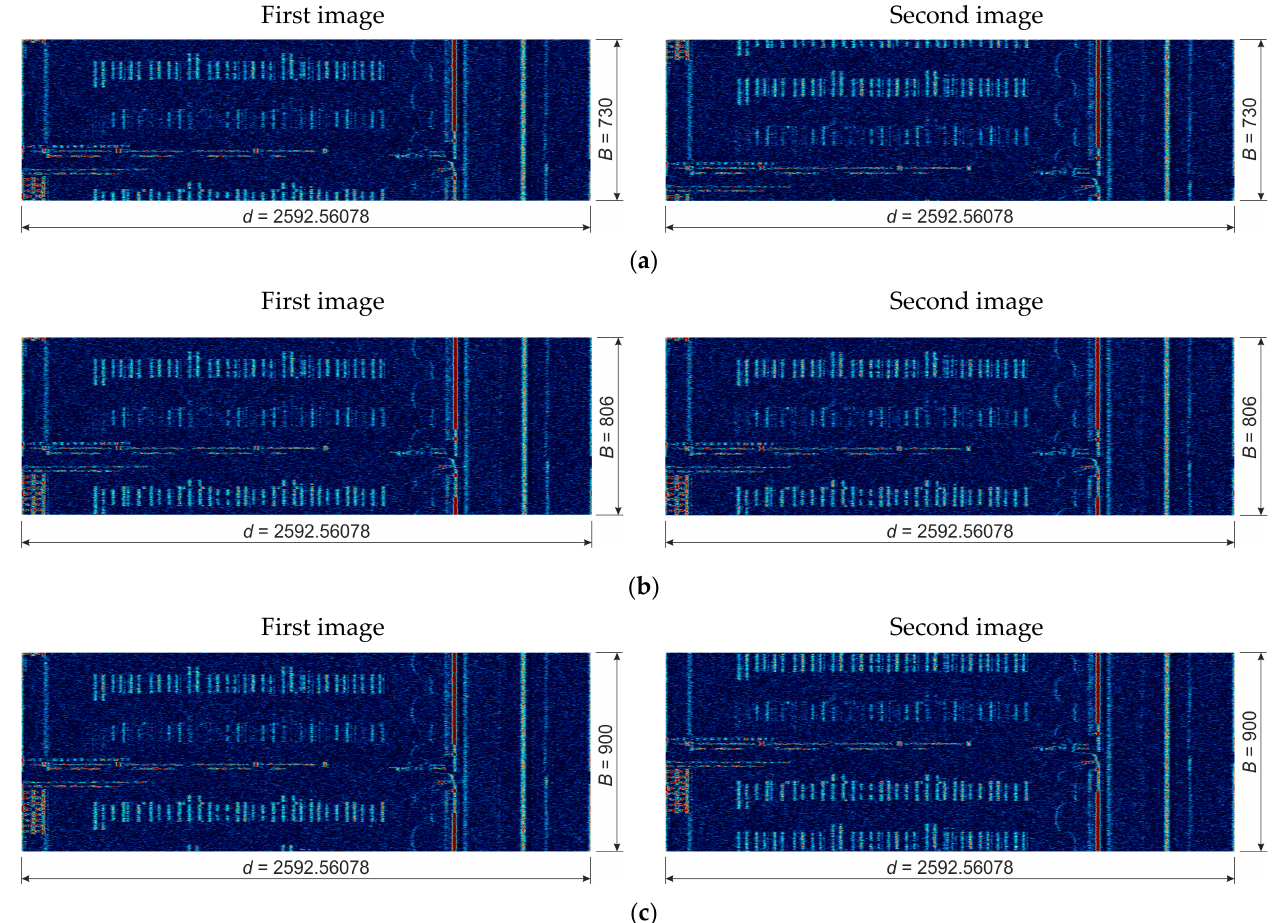
Figure 10. Image reconstructed (two consecutive realizations of the image) from the recorded re- vealing signal for: ( a ) too few image lines, 𝐵 = 730 ; ( b ) correct number of image lines, 𝐵 (cid:3004)(cid:3042)(cid:3045)(cid:3045) = 806 ; revealing signal for: ( a ) too few image lines, B = 730; ( b ) correct number of image lines, B Corr = 806; ( c ) too many image lines, 𝐵 = 900 . ( c ) too many image lines, B = 900